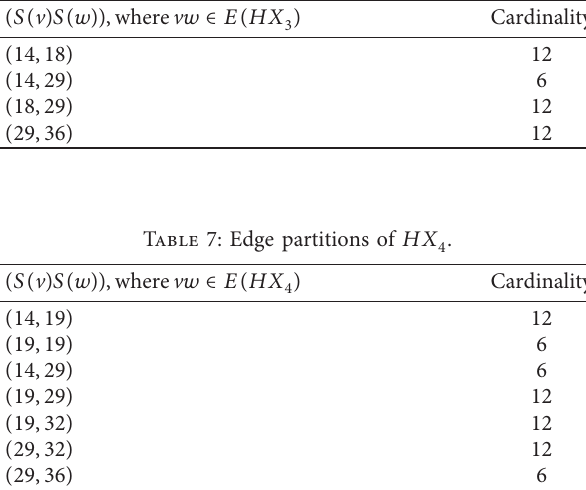
Table 6: Edge partitions of HX